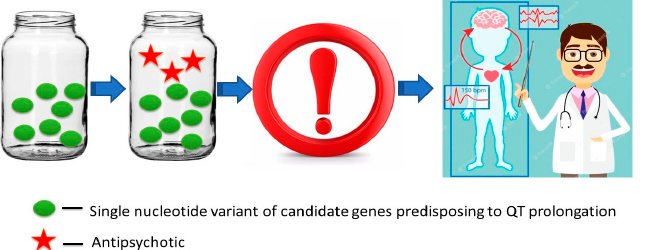
Figure 6. Multifactorial forms of long QT syndrome: the administrations of antipsychotic medications that affect heart rate and conduction calls for caution, especially in polytherapy. Here, dynamic Holter ECG monitoring is required.